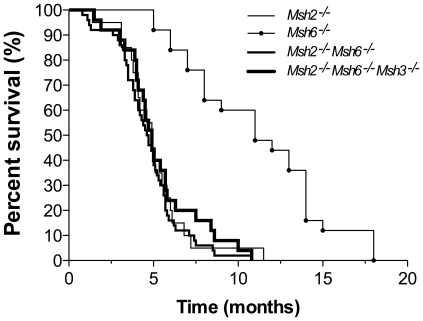
Comparison of the survival curves among MMR deficient mice.
Msh2−/− (N = 20), Msh2−/−Msh6−/− (N = 50) and Msh2−/−Msh6−/−Msh3−/− (N = 25) mice die faster than Msh6−/− (N = 25) (log-rank test p<0.001). The survival curve of Msh6−/− mice was published previously [10].